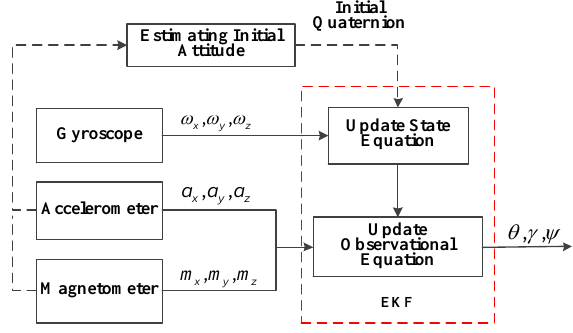
Figure 6. Flow chart of the attitude estimation